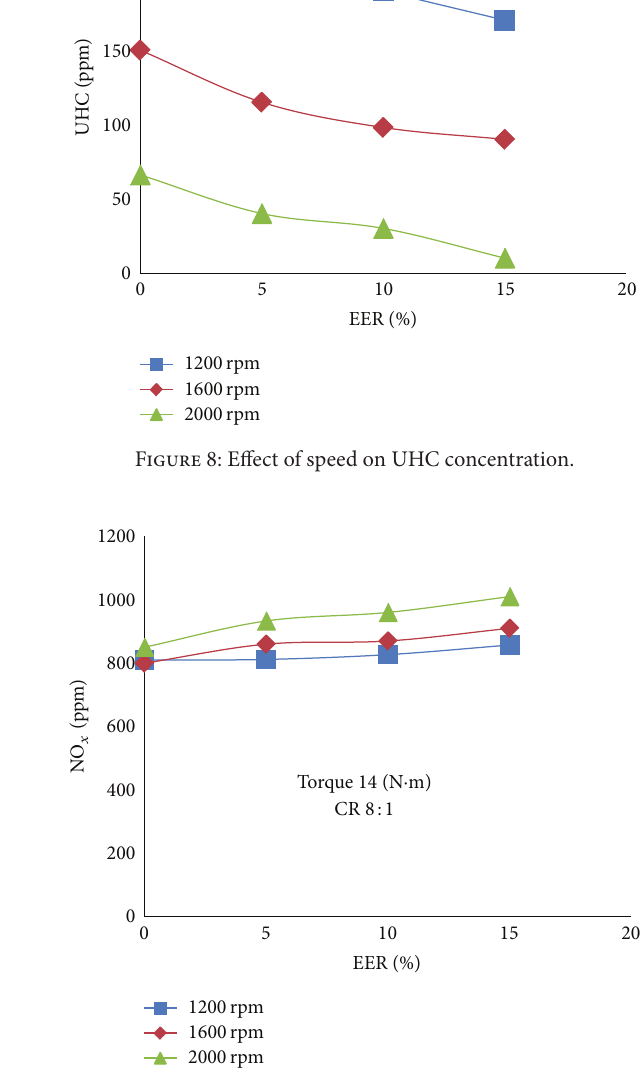
Figure 9: Effect of load on NO x